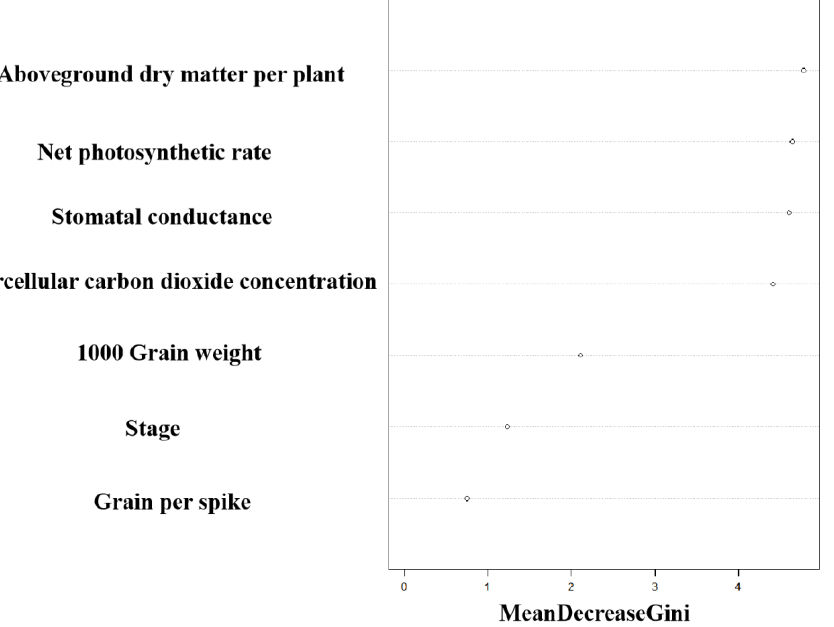
Figure 8. Response of different indexes of wheat cultivars, XN175 and XN765, to border effect (Multi-class area under the curve: 0.9722).